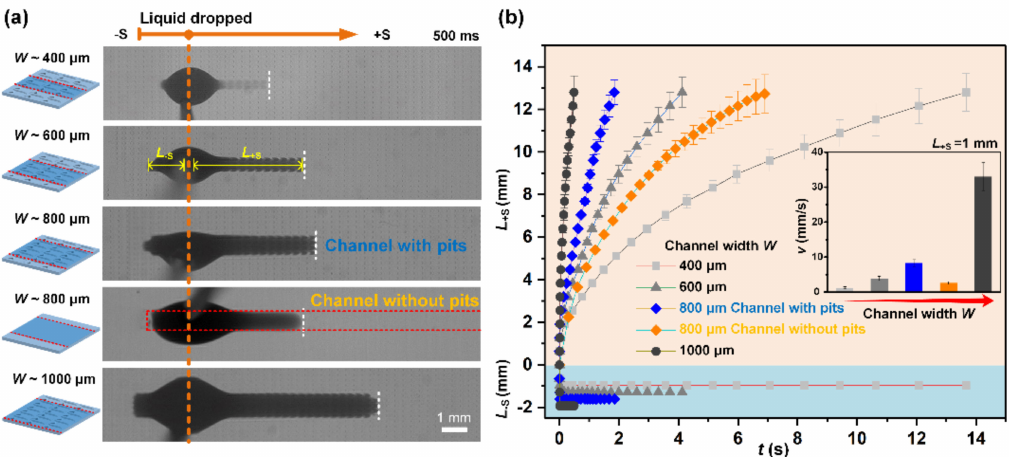
Figure 3. ( a ) In situ observation of liquid transport on STC channels with di ff erent hydrophilic stripe widths at a time of 500 ms. ( b ) Transport distance of liquid as function of time. L + S and L − S are the liquid transport distances in + S and − S direction respectively at same time interval. The inset image shows the average transport velocity of liquid on the channels with di ff erent